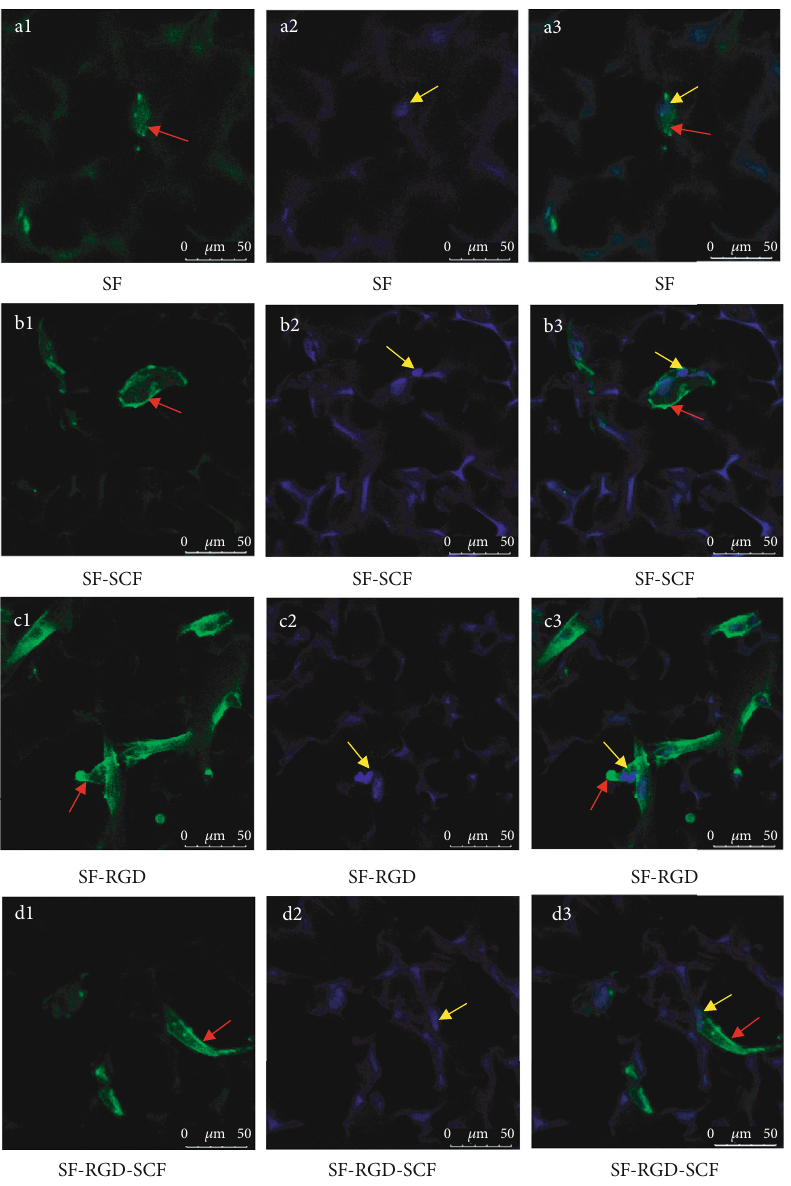
Figure 6: Laser scanning confocal microscopy images of cells on sca ff olds after 1 d seeding. Cell cytoskeletons were stained with Rhodamine Phalloidin (a1, b1, c1, d1). Cell nuclei were stained with Hoechst 33258 (a2, b2, c2, d2). Merged pictures of cell cytoskeletons and nuclei (a3, b3, c3, d3) (red arrows: cell cytoskeletons; yellow arrows: cell